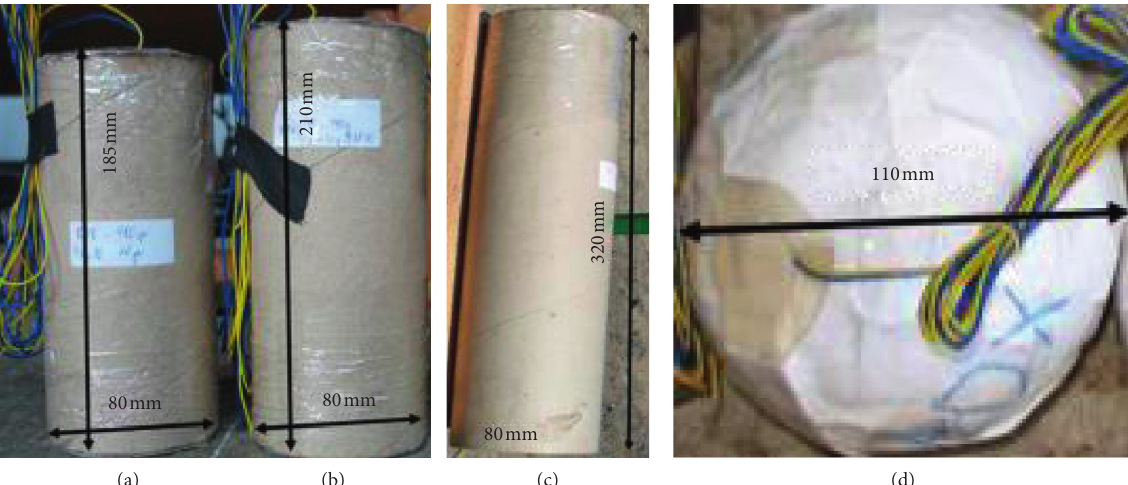
Figure 3: Selection of explosives from the experimental study: (a) RDX cylinder, (b) ANFO, (c) ammonium nitrate, and (d) RDX sphere. In evidence, the size details for the charges.